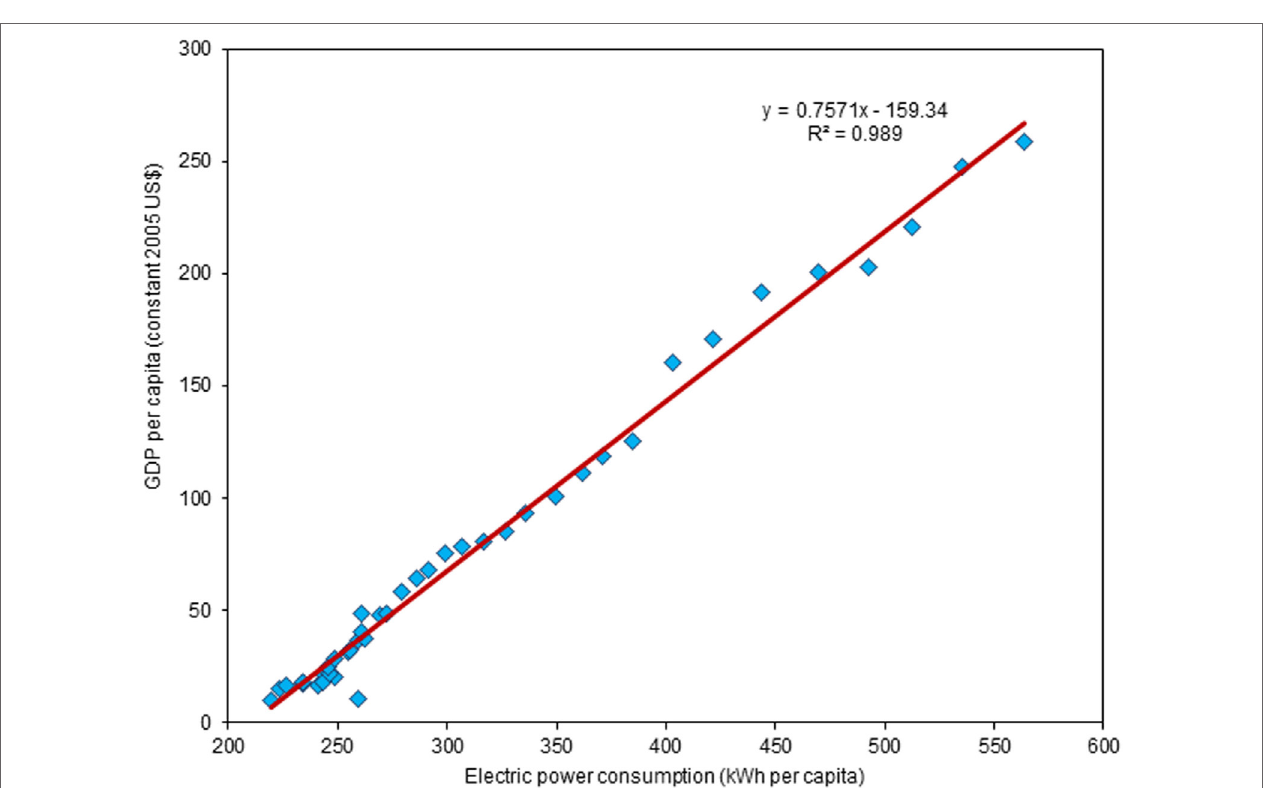
FigUre 2 | GDP per capita vs. electric power consumption for Bangladesh (1971–2011) (WB, 2016).